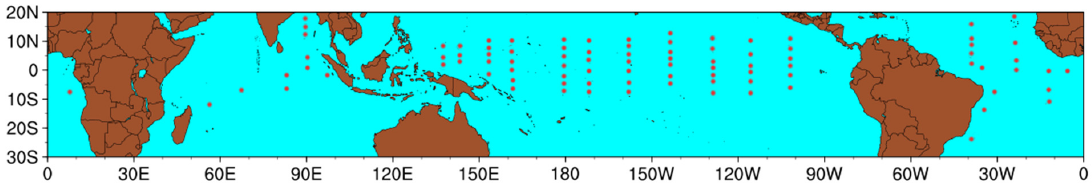
Figure 1. The locations of RAMA (Indian Ocean), TAO (Pacific Ocean), and PIRATA (Atlantic Ocean) moored buoys in the tropical oceans that were used for this study.